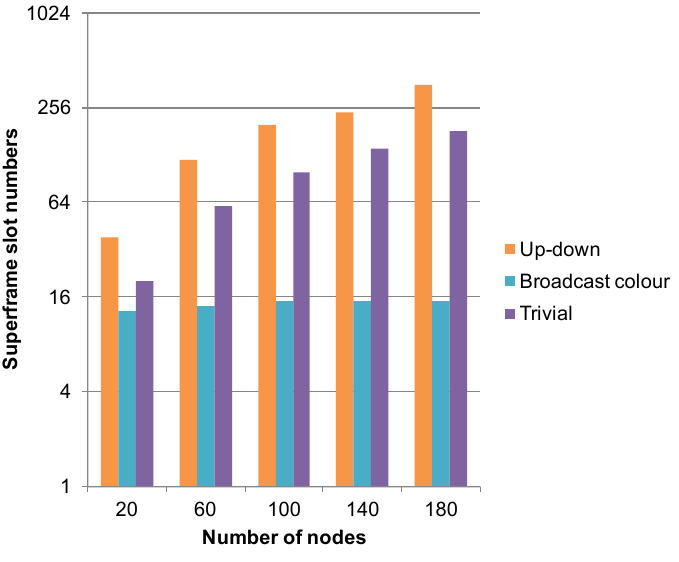
Figure 3. Superframe slot